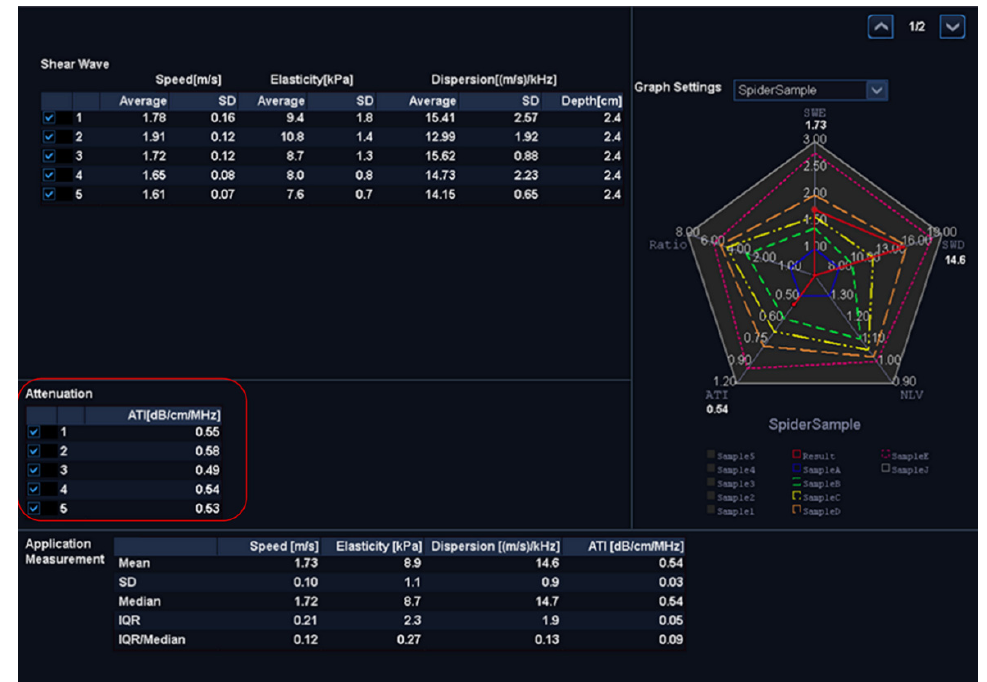
Figure 2. The median ATI from at least five valid data points (red box) with less than 30% of the IQR/median defined as the value of ATI. ATI: attenuation imaging, and IQR: interquartile range.